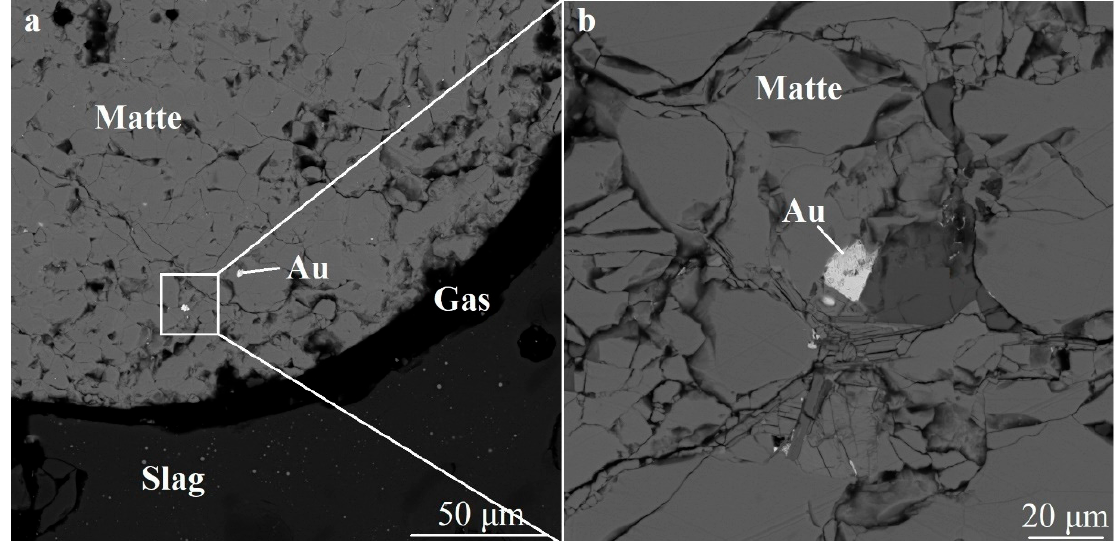
Figure 2. Gold-containing particles in sulfide droplets (Matte) located in the slag and attached to a gas bubble (Gas): ( a ) general view of a sulfide droplet (Matte) in slag, ( b ) enlarged fragment of a sulfide droplet with a gold particle. The slag obtained after melting gold-bearing pyrite ore at a temperature of 1300 °C.